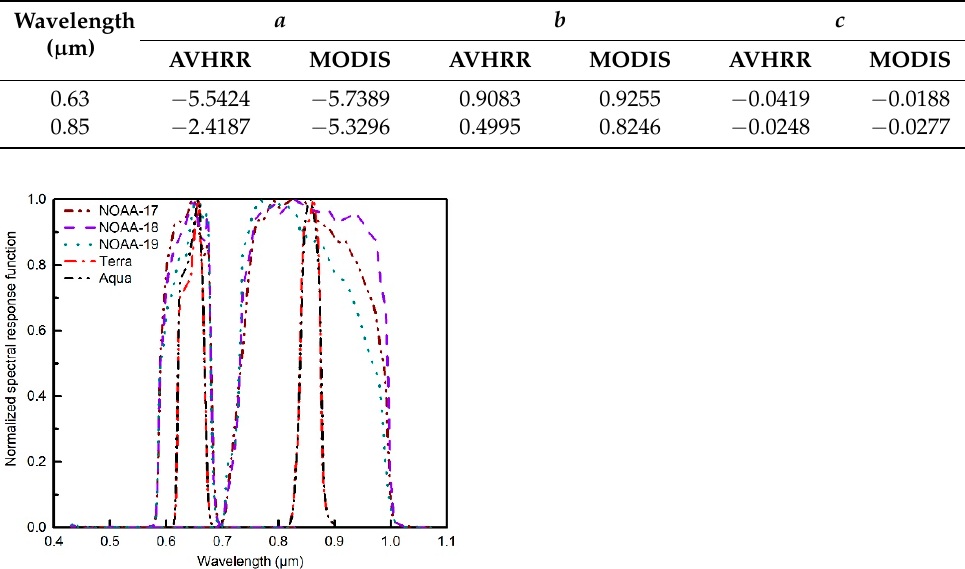
Table 1. Water vapor absorption coefficients of AVHRR and MODIS.